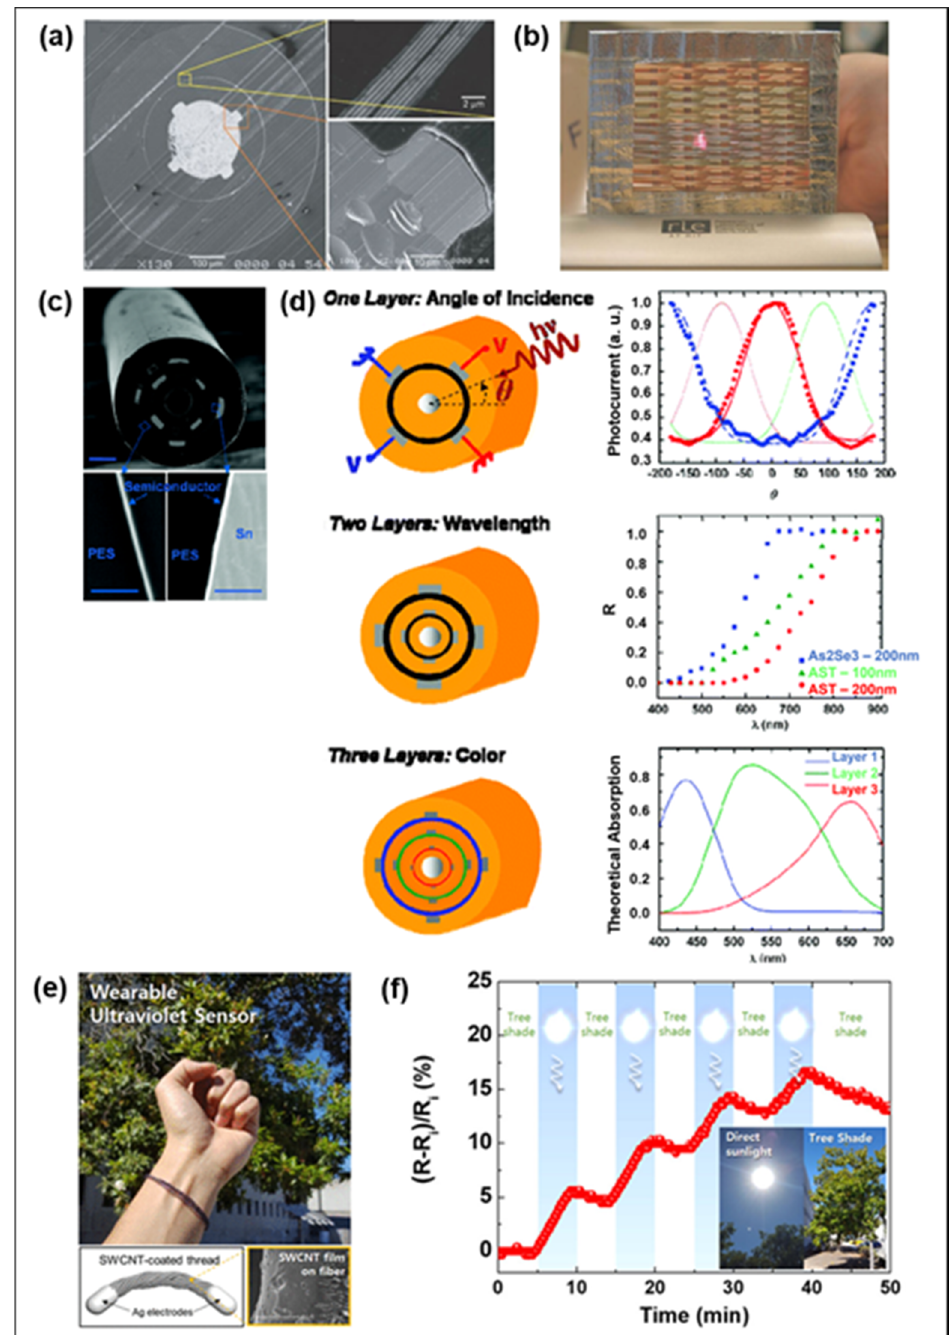
Figure 4. Photosensing fiber. ( a ) Cross-sectional SEM image of the photosensing fiber. ( b ) A woven spectrometric textile. Reproduced with permission from [50], Copyright (2004), Nature Publishing Group. ( c ) Cross-sectional SEM image of the double-layer fiber ( d ) Schematics of 3 types of fibers for detecting the direction, wavelength, and spectrum of incident radiation. Reproduced with permission from [57], Copyright (2009), American Chemical Society. ( e ) Top: UV monitoring fiber is worn on the wrist. Bottom: Schematic and SEM image of the fiber. ( f ) Normalized resistance of the fiber under natural sunlight and tree shade. Reproduced with permission from [33], Copyright (2018), American Chemical